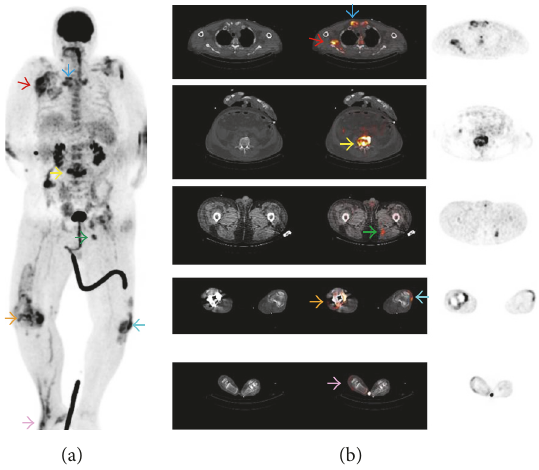
Figure 2: (a) MIP (maximum intensity projection) of FDG PET showing multiple areas of hypermetabolic activity corresponding to disseminated foci of infection and (b) transaxial views of CT, fused FDG PET-CT and FDG PET images representative of several foci of infection disseminated in joints, soft tissues, and lumbar column